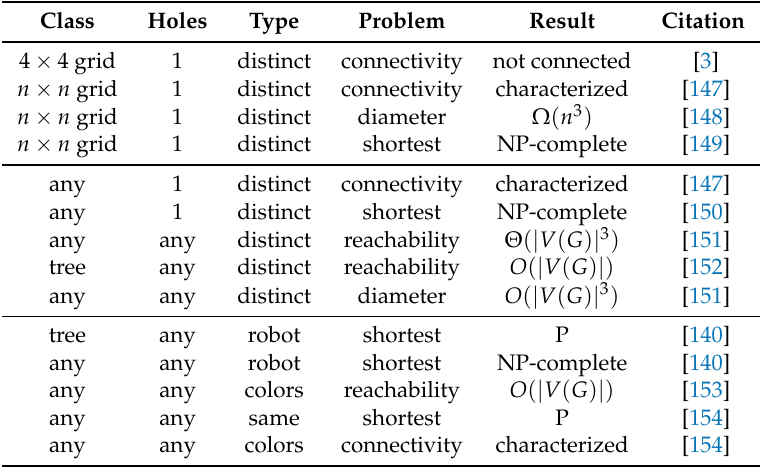
Table 2. Results on the 15-puzzle and